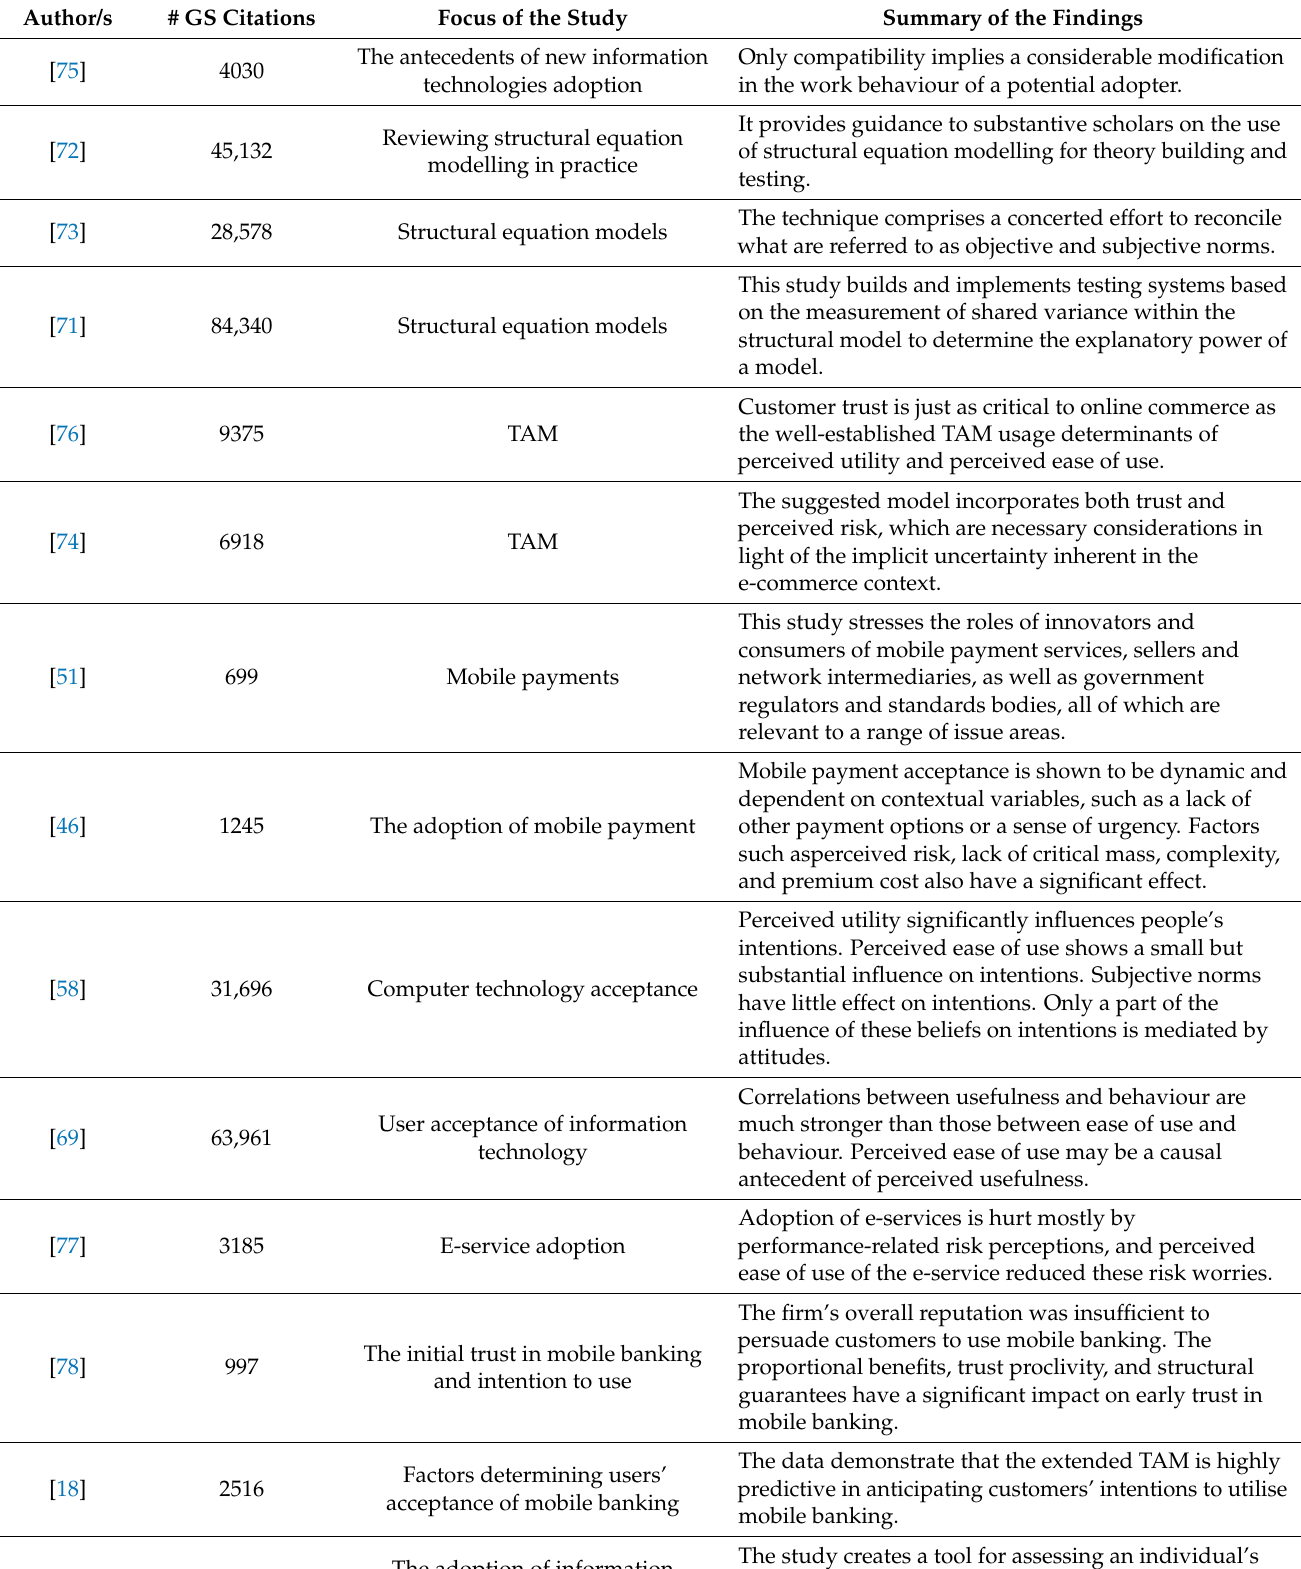
Table 5. Summary of studies in cluster